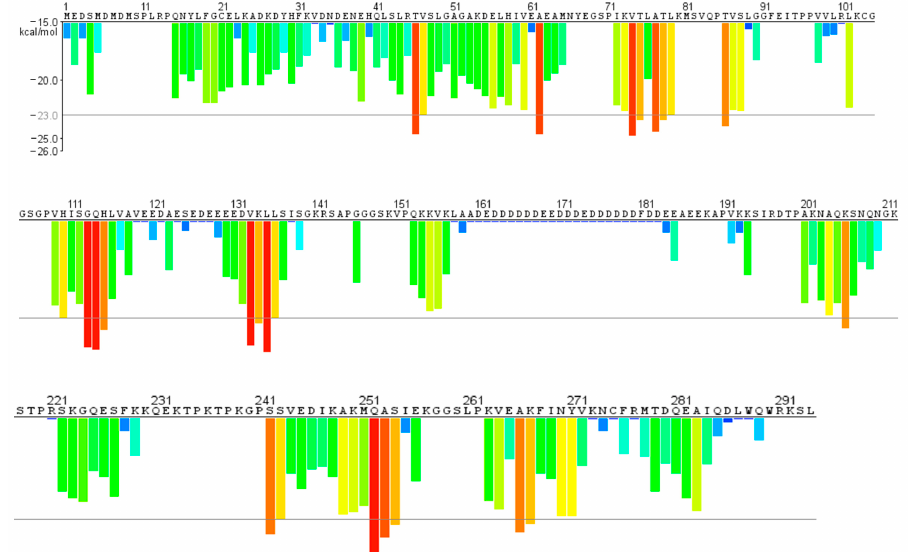
Figure 1. Zippedb predictions of the entire NPM1 1–294 primary